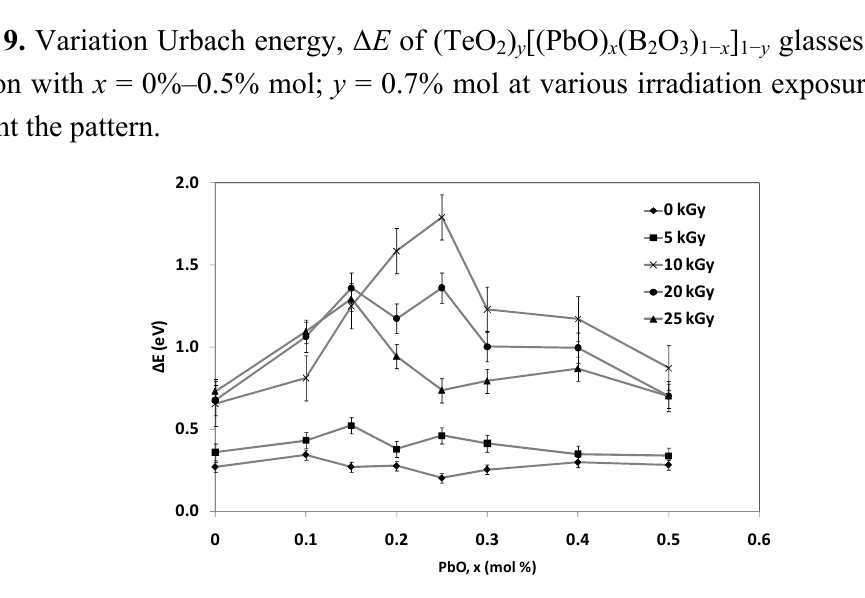
) [(PbO) (B O ) ] glasses for indirect 2 y x 2 3 1 − x 1 − y